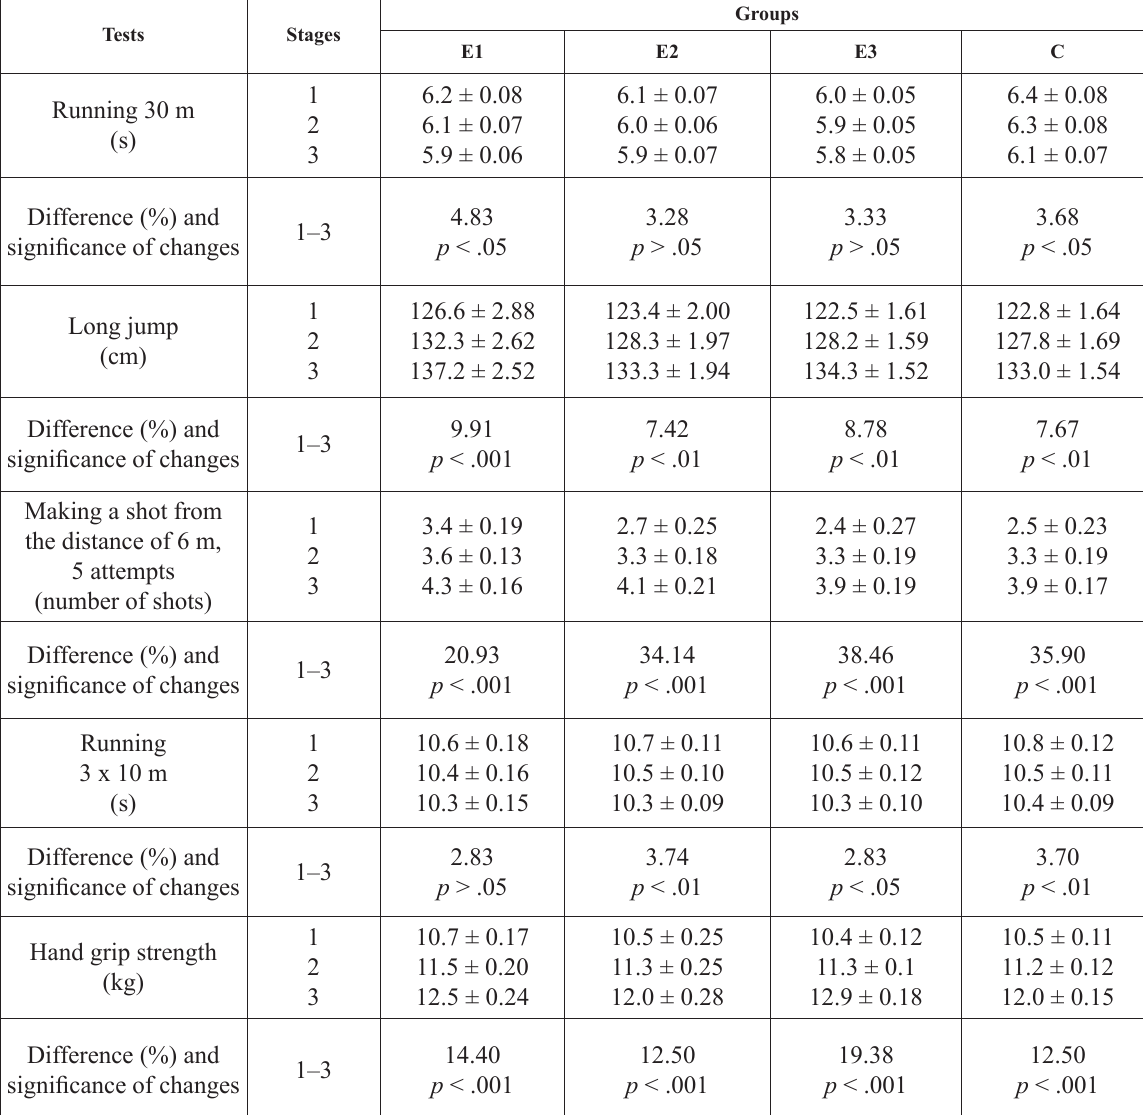
Table 2. Result of changes in general physical fitness for girls, students in the second and the third grades (Х ± Sх